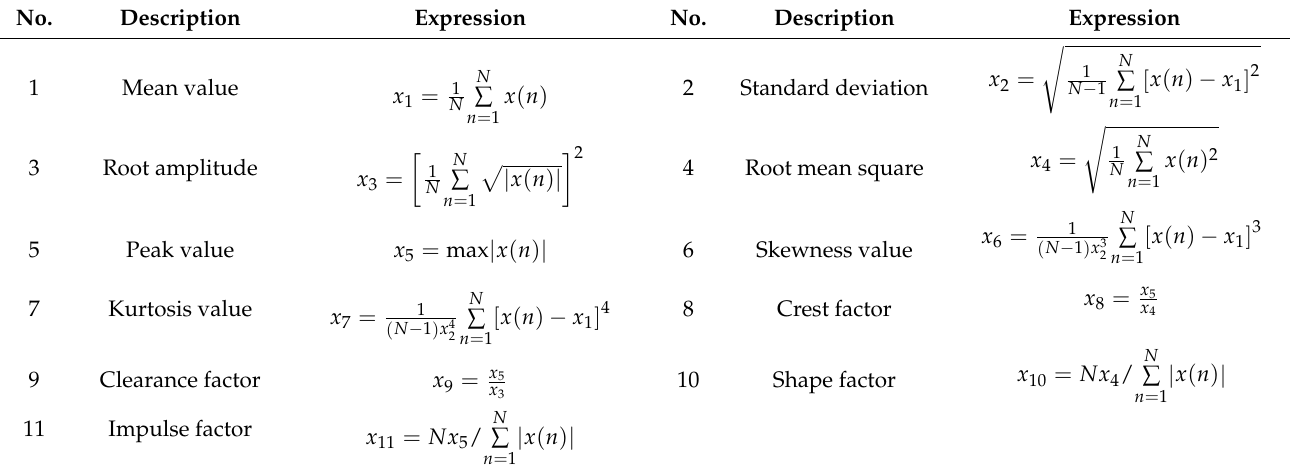
Table 2. Statistical features in the TD.